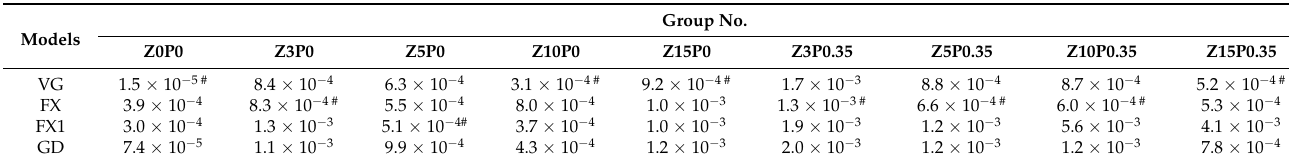
Table 5. Sum of squares of fitting residuals of different SWCC models.